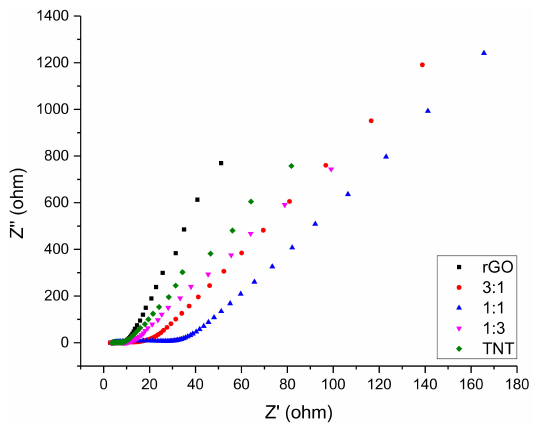
Figure 13. EIS of rGO/TNT composites.